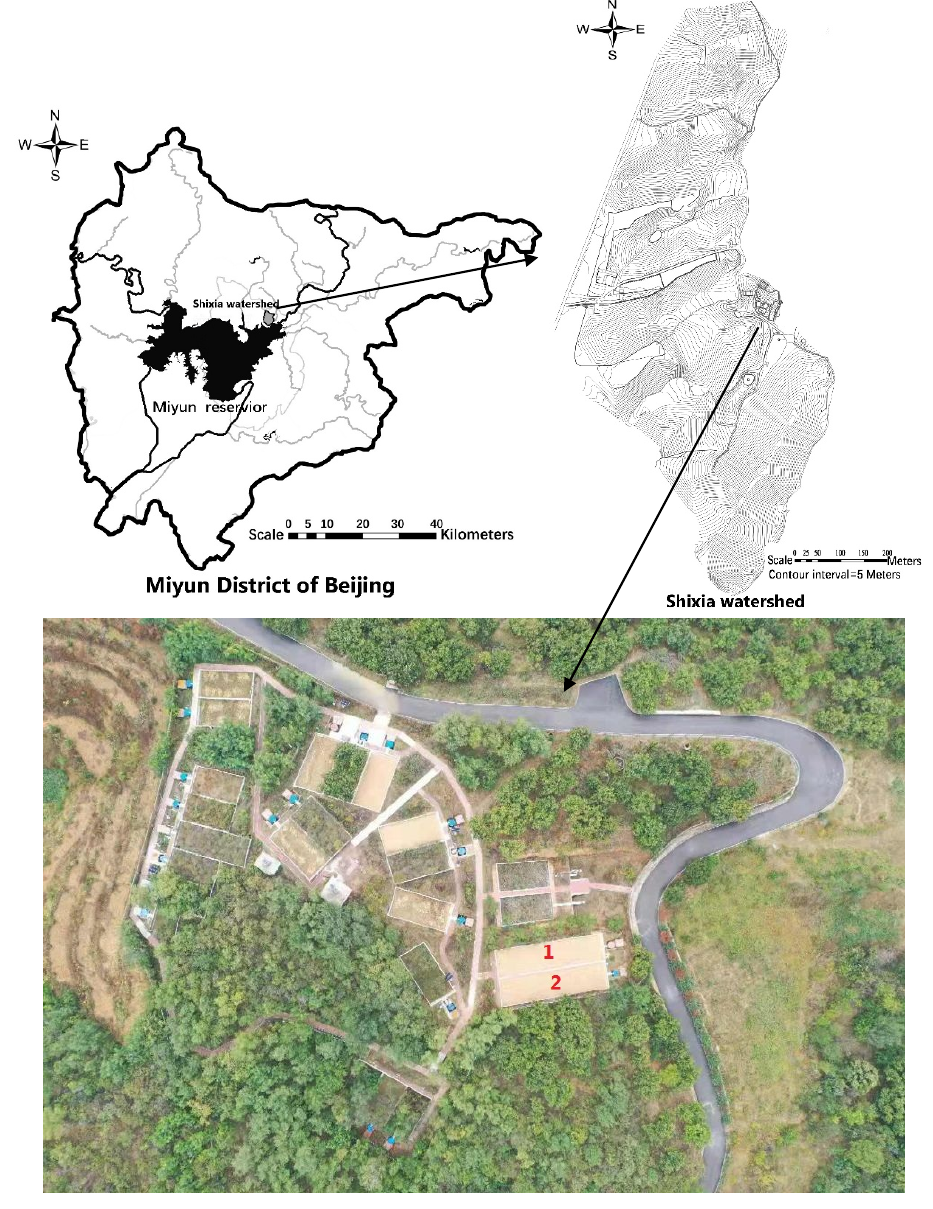
Figure 1. Location of Shixia watershed and runoff plot.